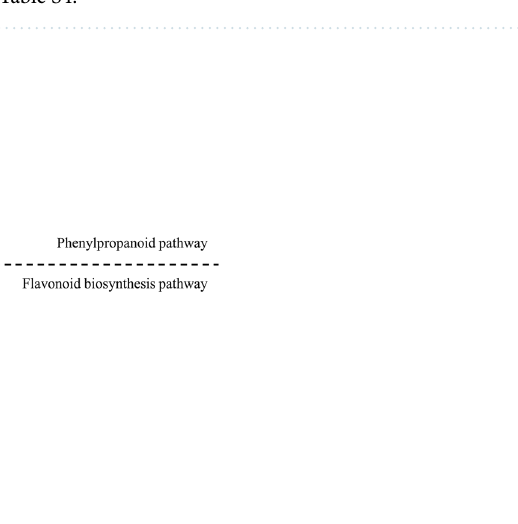
Figure 9. Expression levels of flavonoid biosynthetic genes between large and small flower taxa of Herba Epimedii . Cluster-xxxxx.xxxxxx represents the ID of gene. The x-axis indicates the relative expression level of the genes. Each value is the mean of three replicates, and error bars indicate standard deviations. All samples information is listed in Supplementary Table S4.